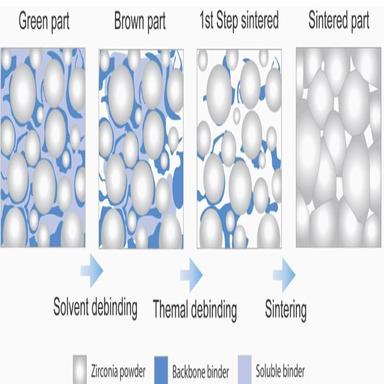
Schematic showing the post-processing process: solvent debinding, thermal debinding, and sintering.